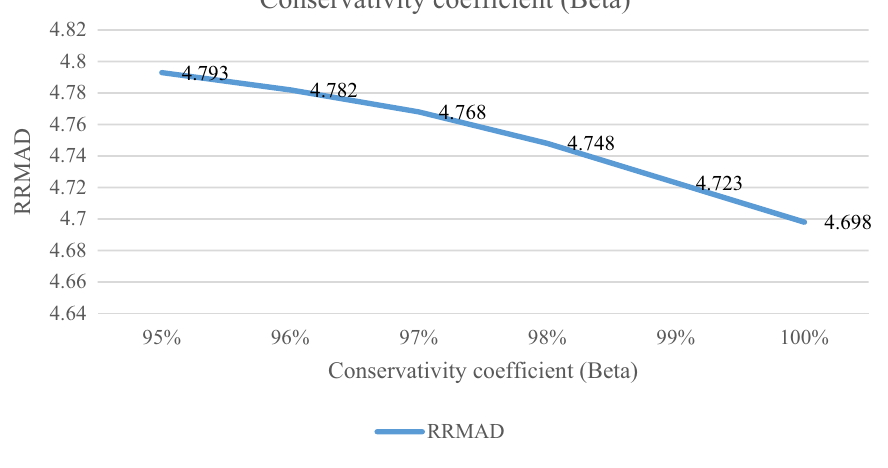
Figure 8. RRMAD for conservativity coefficient.